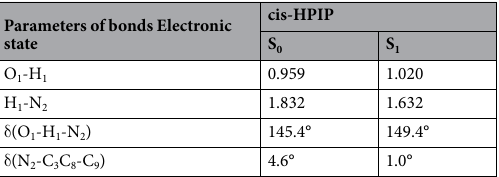
Table 1. The bond parameter (bond length (Å), length angle (°) and dihedral angle (°)) of crucial moiety for the cis-HPIP in the S 0 and S 1 state.